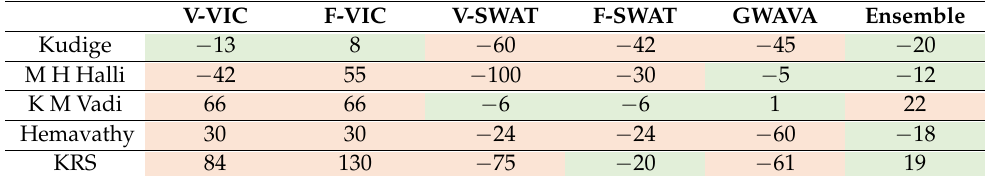
Table 4. The percent bias obtained from monthly streamflow for the five catchments for each model from 1986–2003. The values lying in the green shaded area are considered by this study as ‘good’ and the red area as ‘poor’.